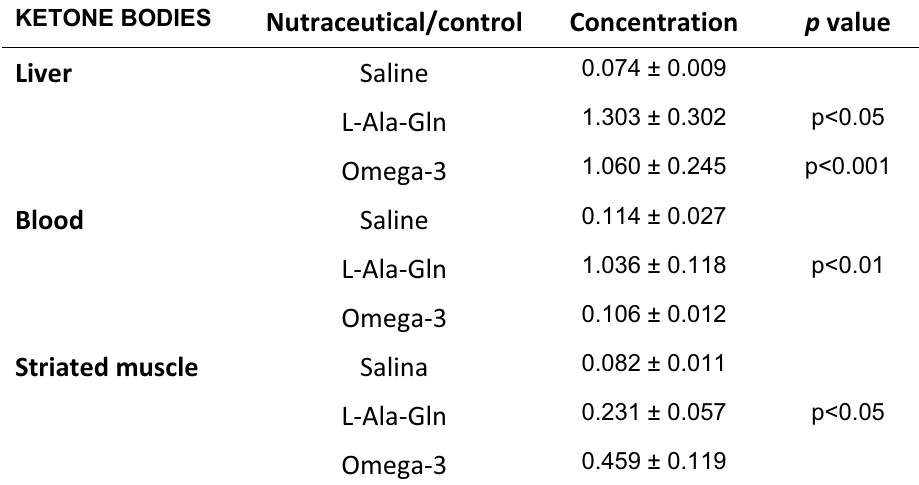
TABLE 4 - Mean ketone bodies concentrations in the blood (µmol/ml) and tissue (mol/g) in groups G1 - treated with saline, G2 - treated with L-Ala-Gln and G3 - treated with Omega-3, 48 hours